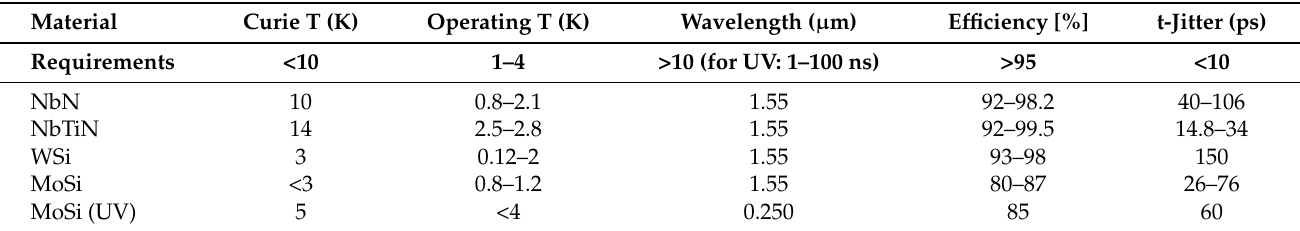
Table 2. SNSPD superconducting material properties and performance for specific designs summa- rized in [73]. Operating prototype WSi sensors for wavelengths close to 10 µ m have been reported in